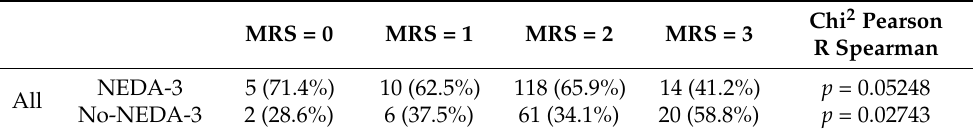
Table 4. Relationship between MRS on platform therapy before switching to the second-line treatment and NEDA-3 in the first year of treatment with natalizumab or